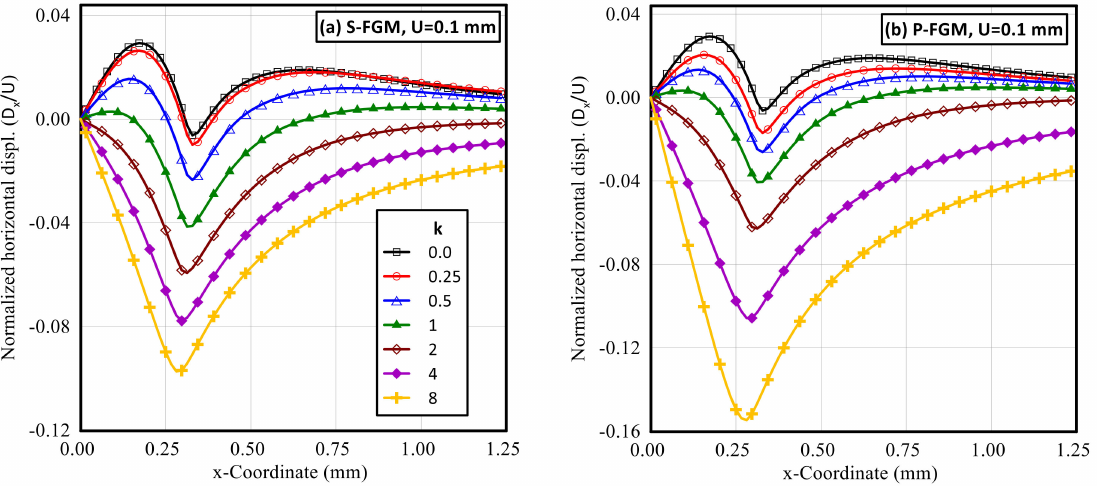
Figure 12. Profiles of the horizontal displacement (at full load) along the upper surface of an elastoplastic Ti/TiB specimen at different gradient indices; ( a ) S-FGM, and ( b ) P-FGM.